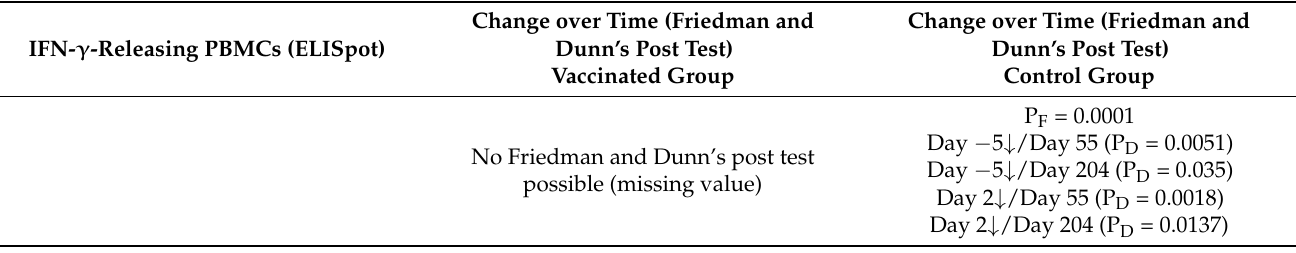
Table A7. Results of Friedman and Dunn’s post test of cytokine mRNA transcription levels after FCV Challenge II. Cytokine